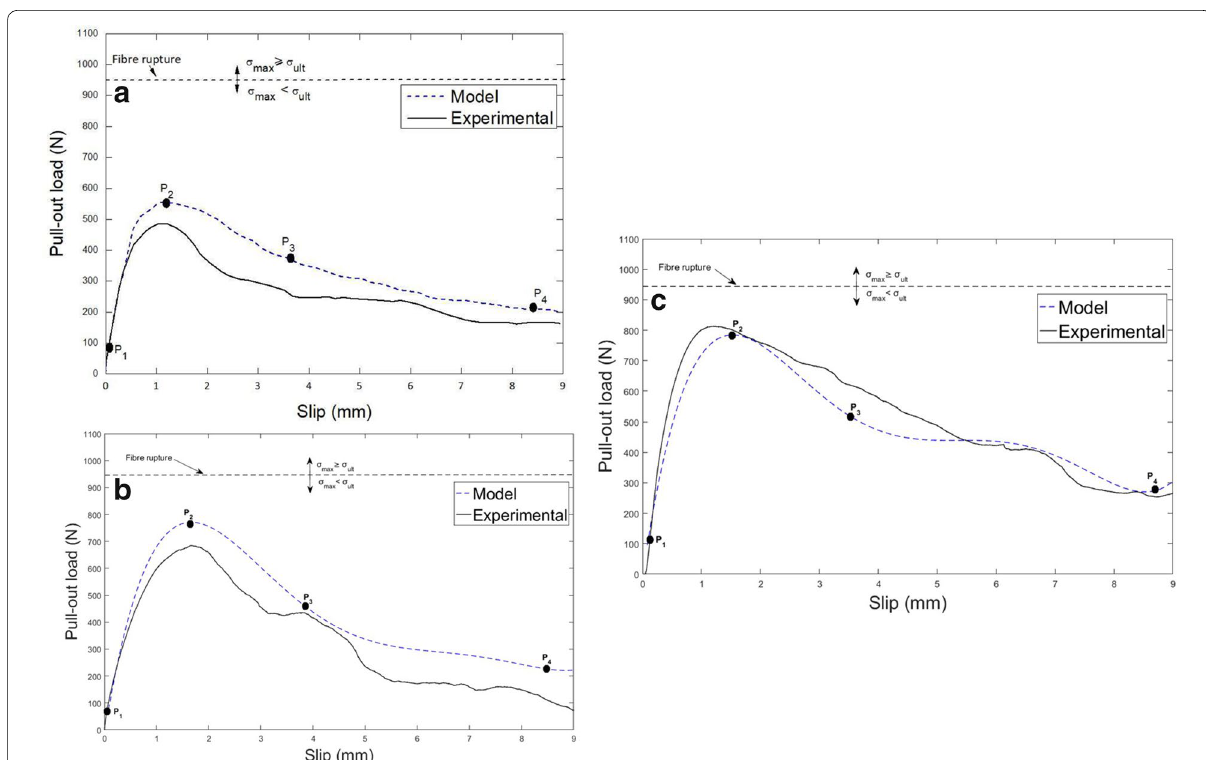
Fig. 18 Comparison of the predicted and experimentally measured pull-out curves for 4DH fibre. a NSC, b MSC and c HSC